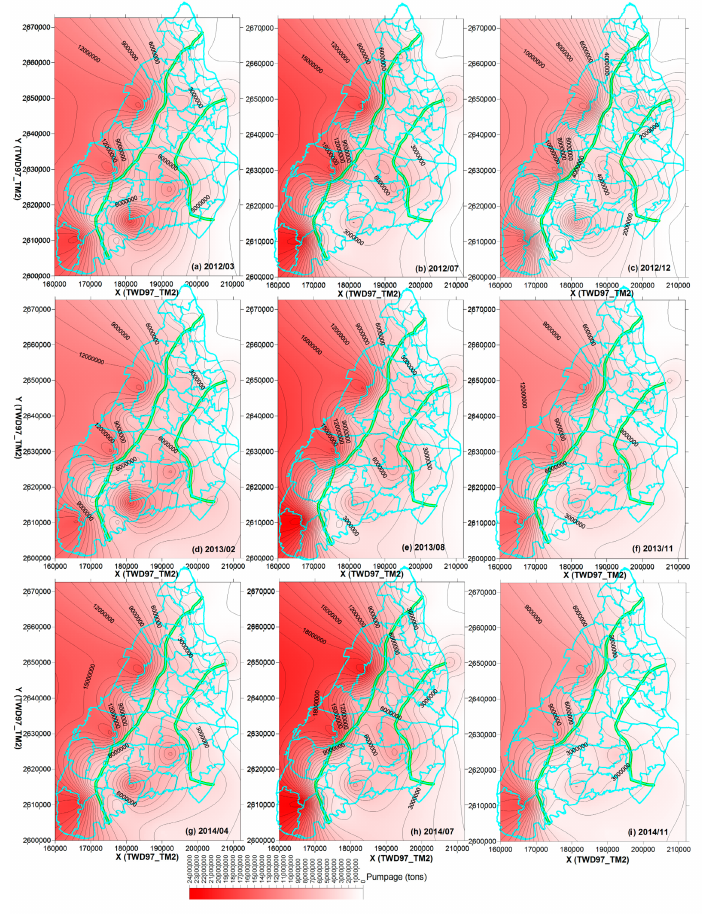
Figure 7. Calculated monthly pumpage of Cho-Shui River alluvial fan during